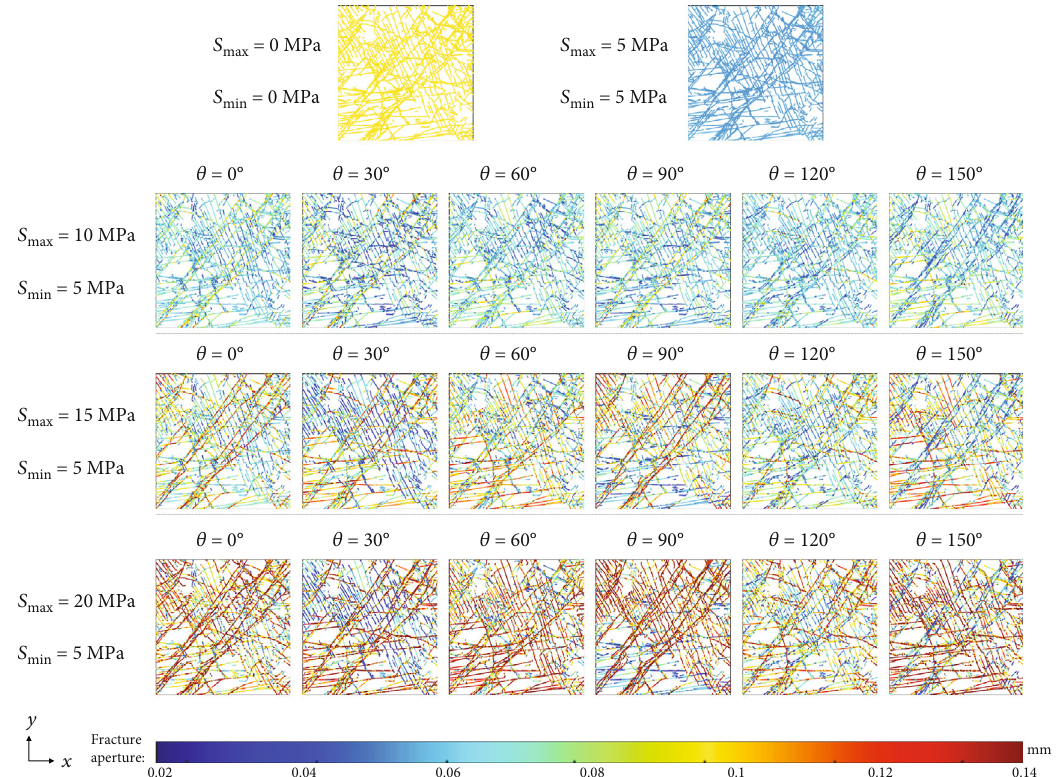
Figure 3: Distributions of fracture apertures in the fracture network under di ff erent stress